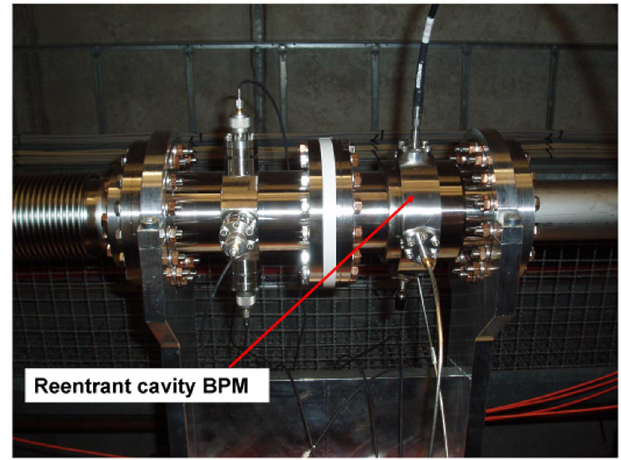
FIG. 8. (Color) Pickup signal spectrum with 0.8 nC beam charge and a macropulse repetition rate around 5